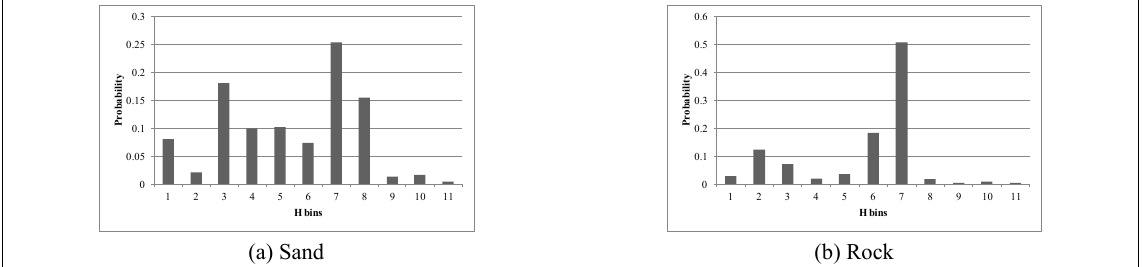
Fig. 3. Color feature extraction– H histogram